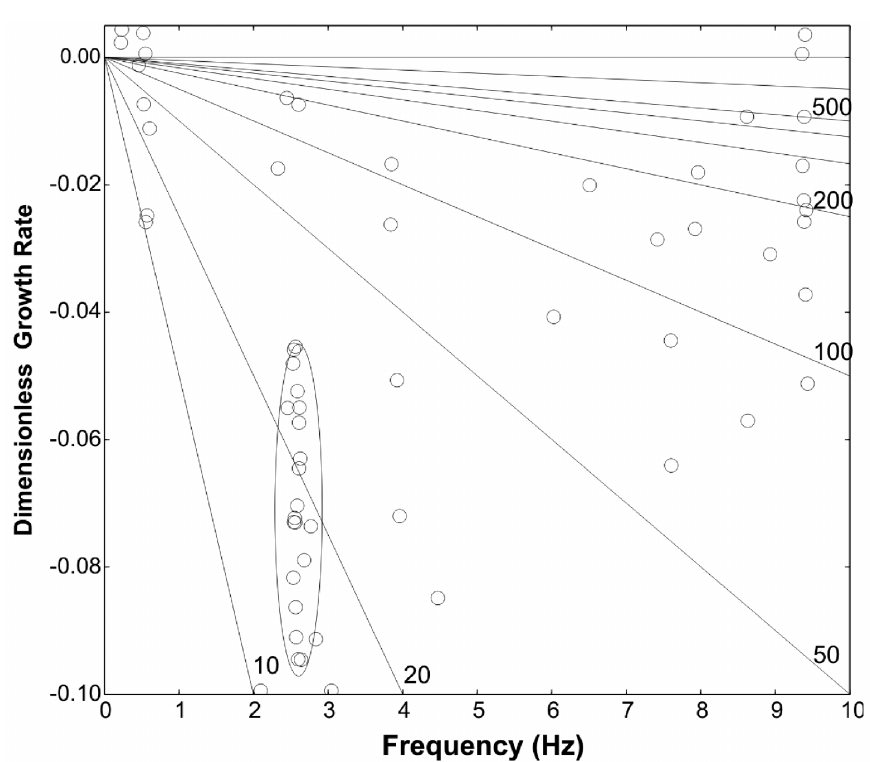
Fig. 5. Frequency, versus growth rate diagram where the complex frequencies for different trial AR orders be- tween 20-60 are plotted. Areas of the diagram that are densely populated represent stably determined complex frequencies and indicate Q-values near 20, while scattered points indicate incoherent